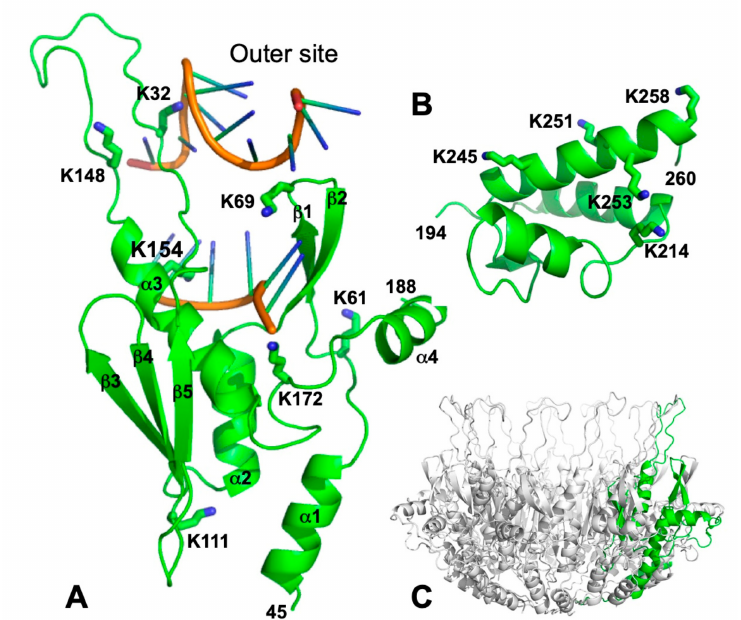
Figure 1. Structural model of Red β and mapping of possible DNA binding sites. ( A ) Model of the core of the DNA binding domain of Red β (residues 45-188) based on homology with Rad52 [15]. Seven lysine residues are shown in stick form and labeled. The backbone conformation around K172 has been adjusted to more closely match the structure of Rad52, which has a glycine at the equivalent position. Two segments of ssDNA, aligned from structures of complexes with the Rad52 DNA-binding domain [13], are shown with their sugar-phosphate backbones in orange. The ssDNA at the “inner” site in the middle of the figure is from PDB 5XRZ. Notice that this ssDNA is bound in an extended conformation with its bases exposed for homology recognition. This ssDNA is present in the crystal as a dT40 oligonucleotide that wraps around an 11-mer ring with 4 nt/monomer (as shown in Figure S1a). The ssDNA at the “outer” site is from PDB 5XS0. Notice that it is bound in a right-handed helical conformation. The two ssDNAs were not bound simultaneously to Rad52 (as depicted here for Red β ) but rather were taken from separate crystal structures [13]. ( B ) Structure of the Red β CTD with five lysine residues labeled. The coordinates are from PDB 6M9K [26]. The orientation relative to the NTD in panel A is hypothetical, but the two are positioned with nearest connecting residues juxtaposed. ( C ) Model of the Red β DNA binding domain in an 11-mer ring, based on Rad52 [15]. The subunit highlighted in green is in a similar orientation as that in panel